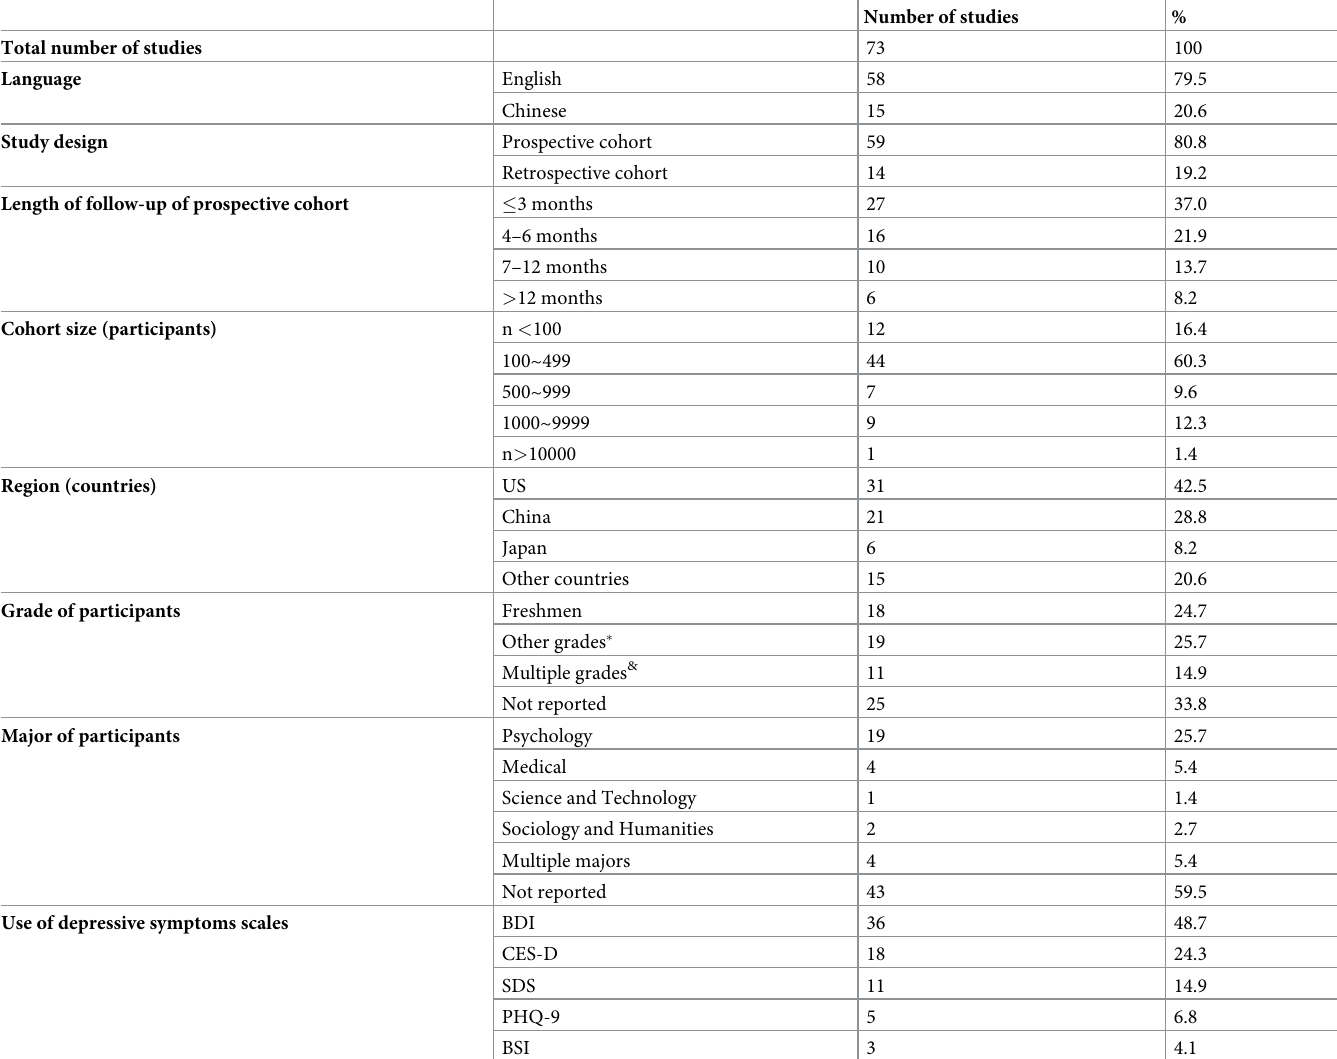
Table 1. The characteristics of included